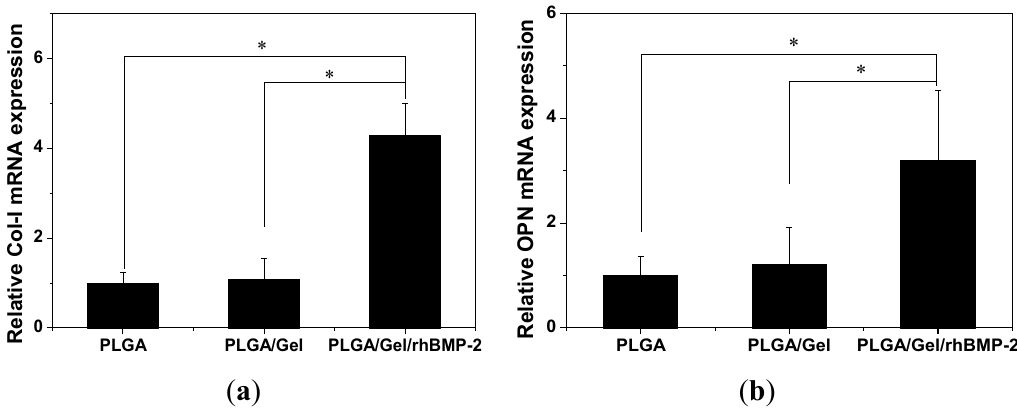
Figure 9. ALP activities of BMSCs in PLGA, PLGA/Gel, and PLGA/Gel/rhBMP-2 scaffolds during 14-day in vitro culture ( a ); Calcium deposition after culturing in PLGA, PLGA/Gel, and PLGA/Gel/rhBMP-2 scaffolds for 14 and 21 days ( b ). The data were represented as mean ± standard deviation (SD; n = 3; * p < 0.05).